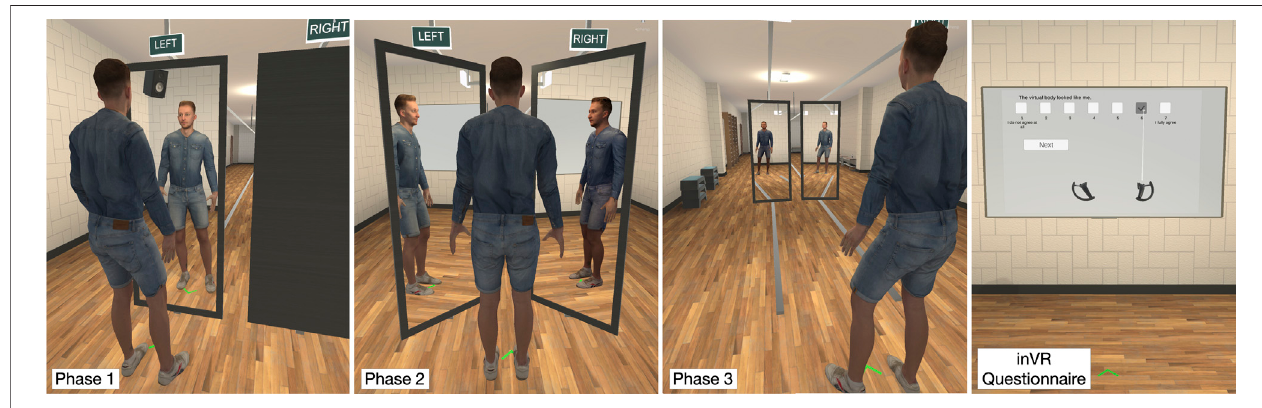
FIGURE 3 | The three phases of the VR exposure and the VR questionnaire system.